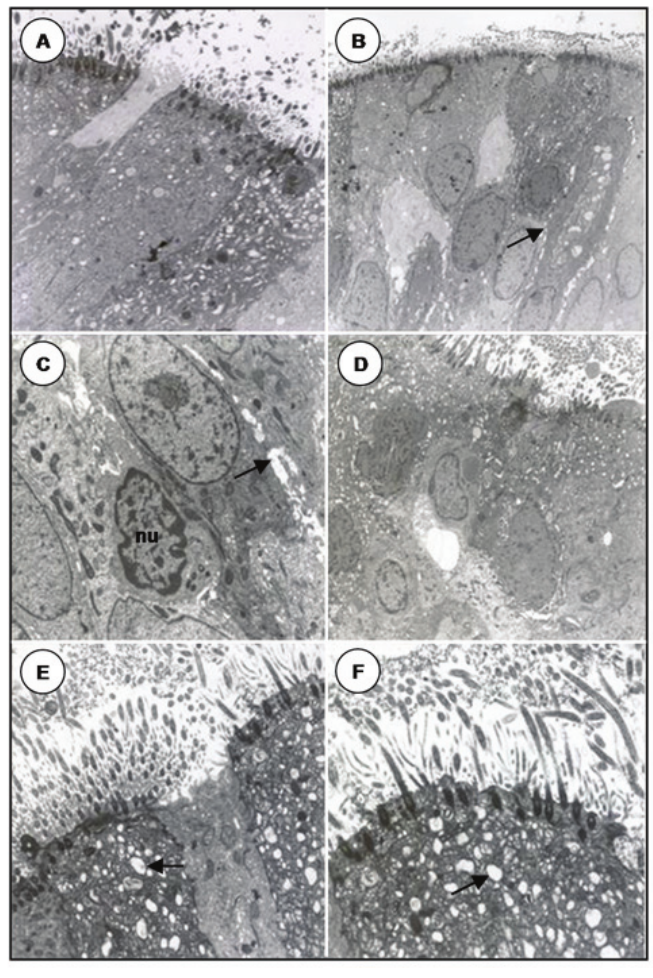
FIGuRE 7 - Proximal tracheal epithelium (ET group). A – ciliary desorientation and rarefaction on epithelial surface; B, C and d – cell junction widening (arrows), picnotic nucleus with condensed chromatin (nu); E and F – cytoplasmic vacuolozation (arrows), ciliary rarefaction and disorganization. TEM ( A – 7.750X; B – 3.250X; C – 5.750X; d – 7.750X; E – 9.750X; F –